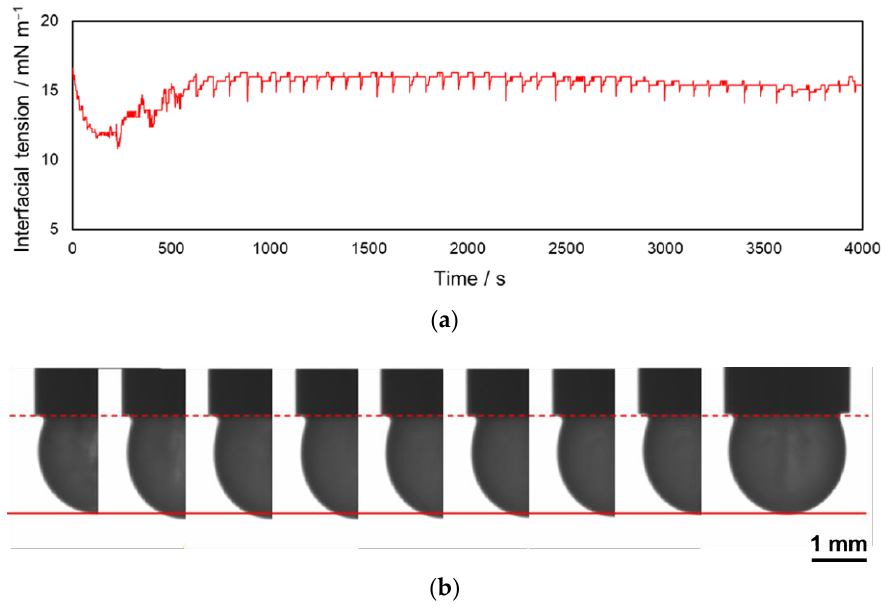
Figure 1. ( a ) Representative variation of interfacial tension synchronized with repetitive cycles of pendant droplet between contraction and expansion. ( b ) Series of images of the contracting and expanding process of the pendant-droplet (33 ms interval).